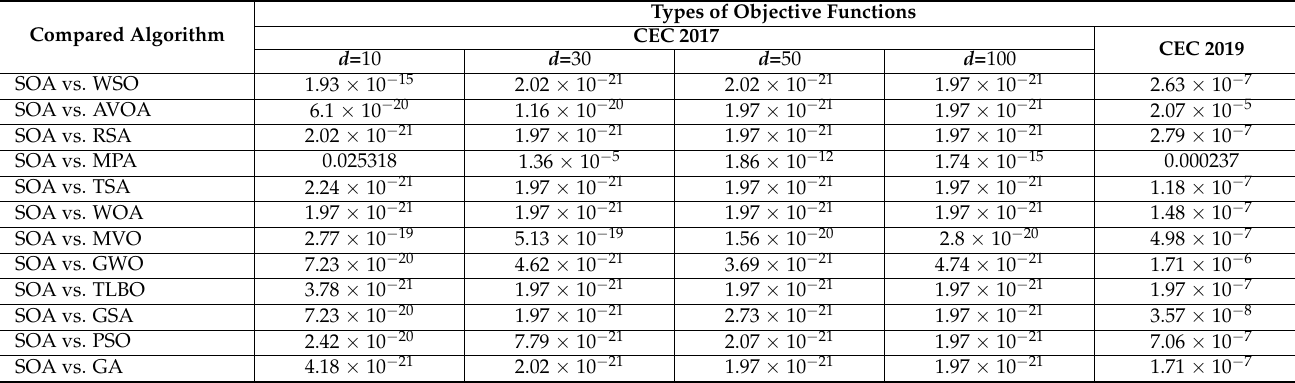
Table 7. Wilcoxon rank sum test